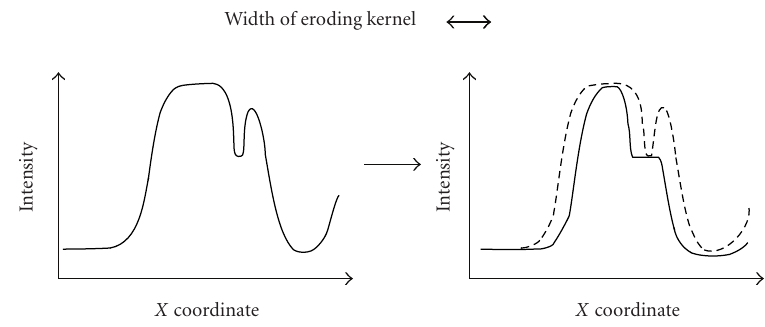
Figure 2.2. Grayscale erosion using a disc shaped structuring element. The graphs show a vertical cross section through a grayscale image (Source: